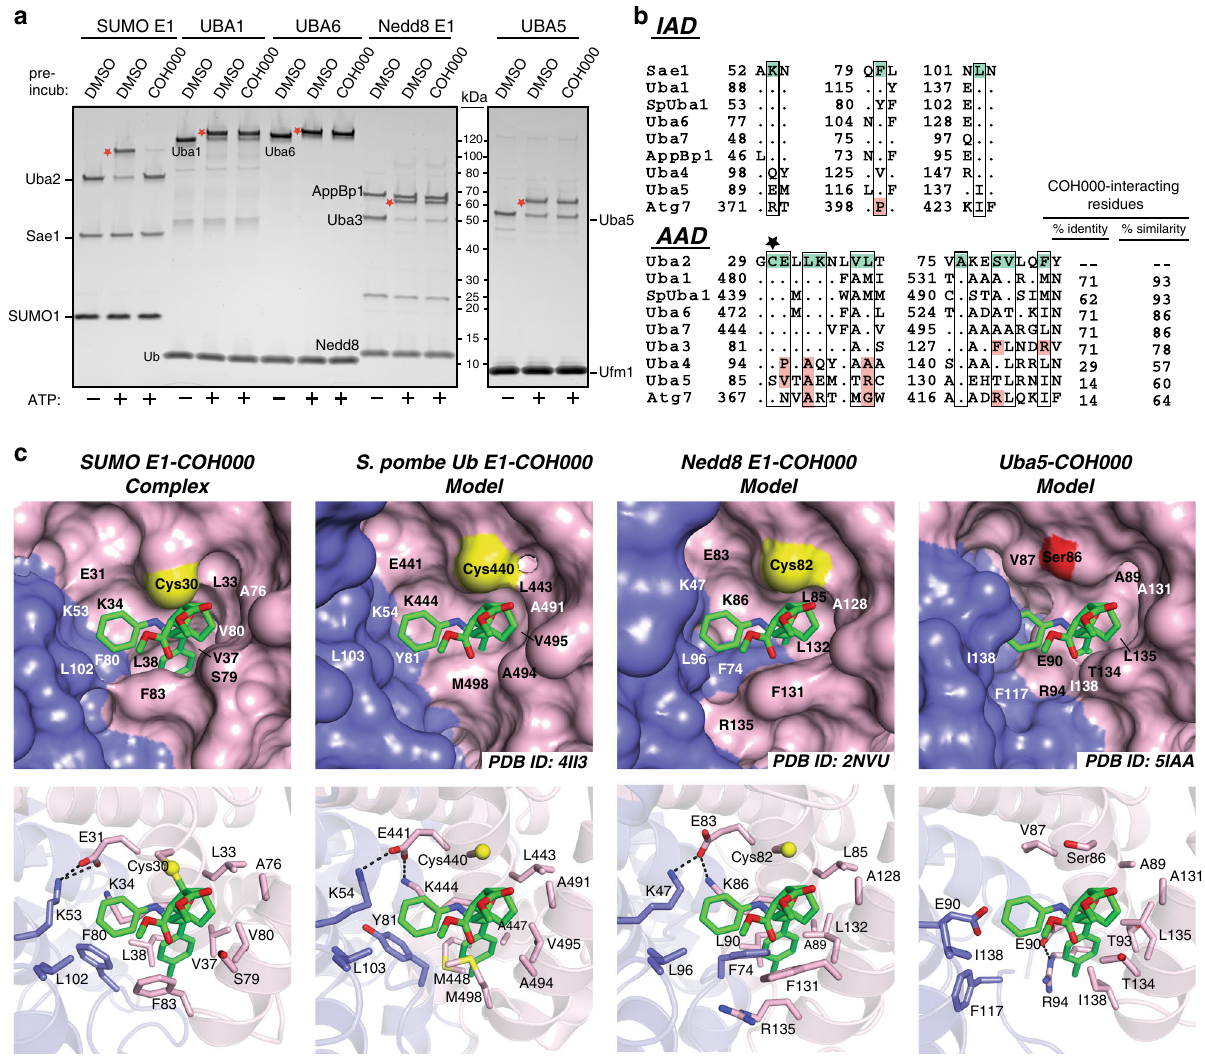
Fig. 5 Insights into the molecular basis of COH000 speci fi city for SUMO E1. a In vitro E1 – Ubl thioester formation assays were performed as described in the Methods. The samples were subjected to SDS-PAGE and visualized with Sypro Ruby stain. The E1 – Ub thioester products are indicated with a red star. b Structure-based sequence alignment of the COH000-interacting region of the indicated Ub and Ubl E1 enzymes. Residues involved in contacts to COH000 in the SUMO E1 COH000 structure are shaded green and the cysteine residue that forms the thioether bond with COH000 (Cys30) is indicated with a black star. Residues of other Ubl E1s at positions corresponding to the COH000 binding site of SUMOE E1 that are identical are indicated by periods and those that harbor different physicochemical properties are shaded red. The percent identity and similarity of Ubl E1 residues corresponding to the COH000 binding site of SUMO E1 are shown to the right of the alignment. ‘ Sp ’ stands for S. pombe . c Models of Ubl E1-COH000 complexes were created by superimposing the adenylation domains of Ubl E1s onto the SUMO E1 COH000 structure. c (top) The indicated Ubl E1 structures are shown as surface representations with a magni fi ed view of the region corresponding to the COH000-interacting pocket observed in the SUMO E1 COH000 structure. The g1/ g2 regions of the Ubl E1s are not shown because they occlude the cryptic COH000 binding pocket. The SUMO E1 COH000 structure is shown in the same orientation in the left panel for comparison. Cys30 of SUMO E1 and the corresponding cysteines/serines of other Ubl E1s are colored yellow and red, respectively. Ubl E1 residues corresponding to the COH000 binding site of SUMO E1 are labeled. c (bottom) The structures are shown as cartoon representations with Ubl E1 residues corresponding to the COH000 binding site of SUMO E1 shown as sticks and